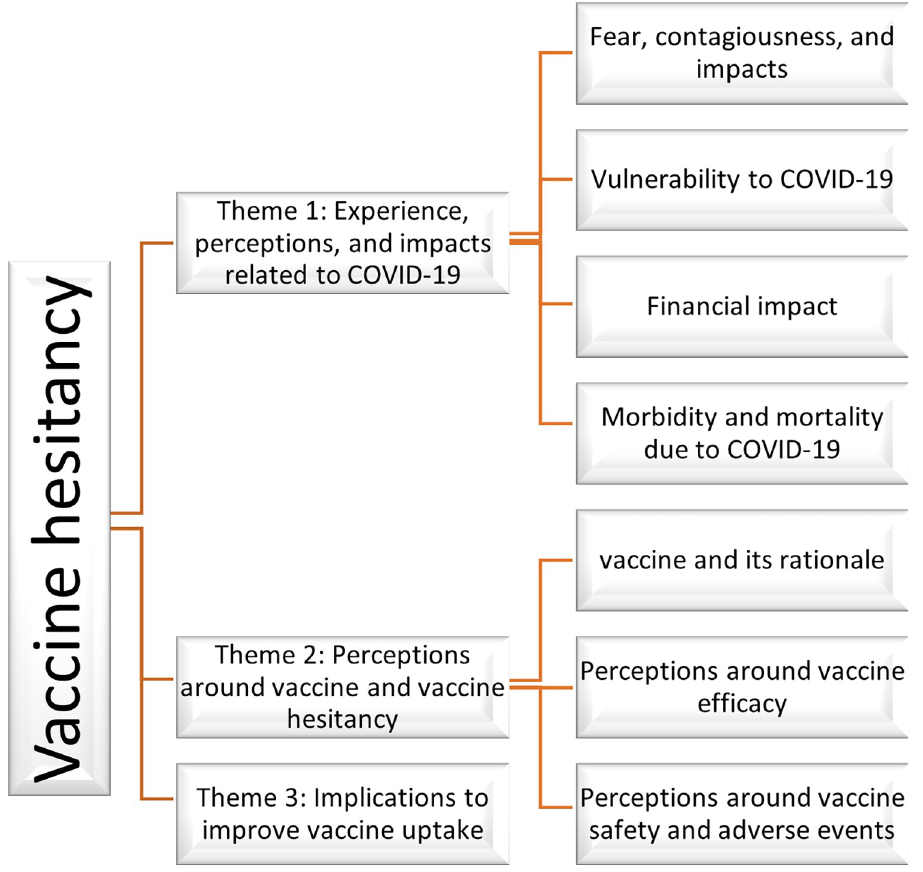
Fig 1. Thematic analysis demonstrating hierarchy of